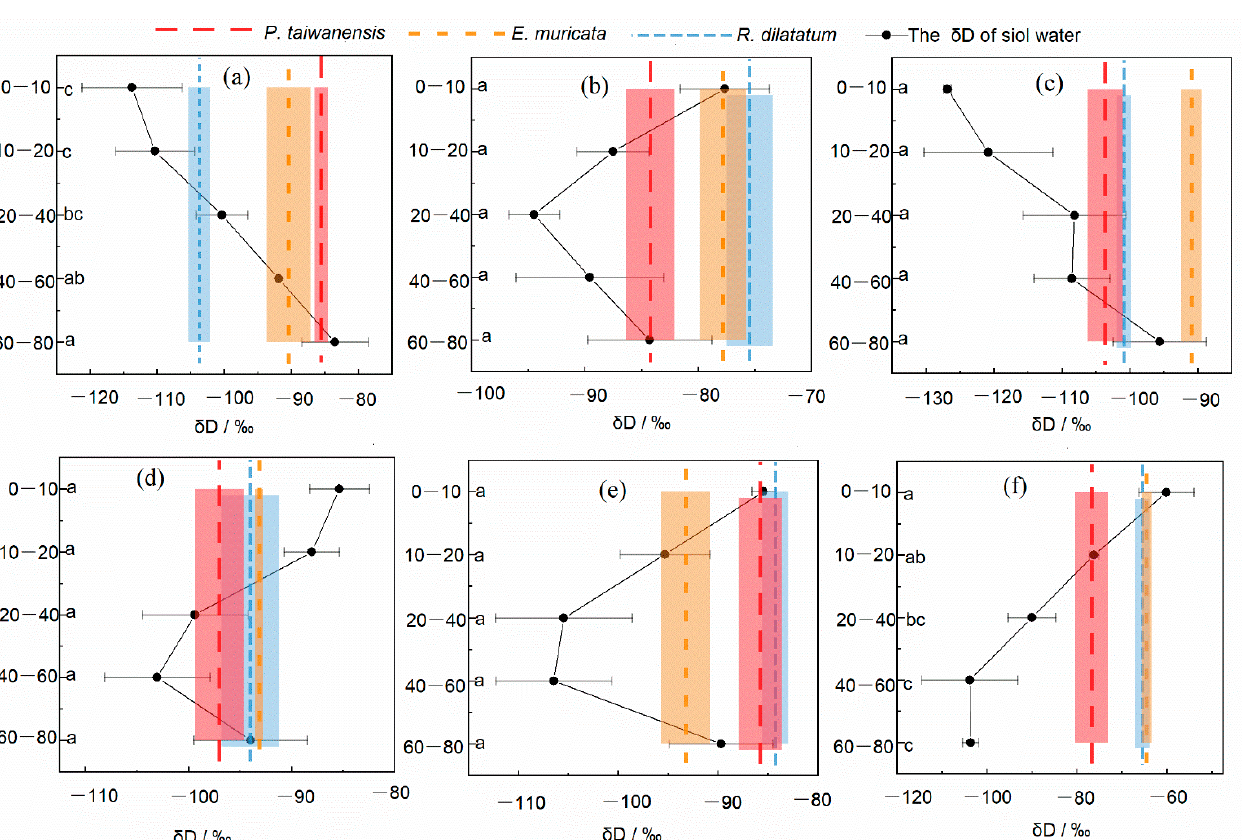
Figure 6. Seasonal variations of δ D in soil horizons (0–80 cm) and xylem water (vertical dash) from P. taiwanensis and understory shrub species. Error bars and column widths represent standard errors (N = 3). ( a – f ) represent the chronological months from July to January of the following year.